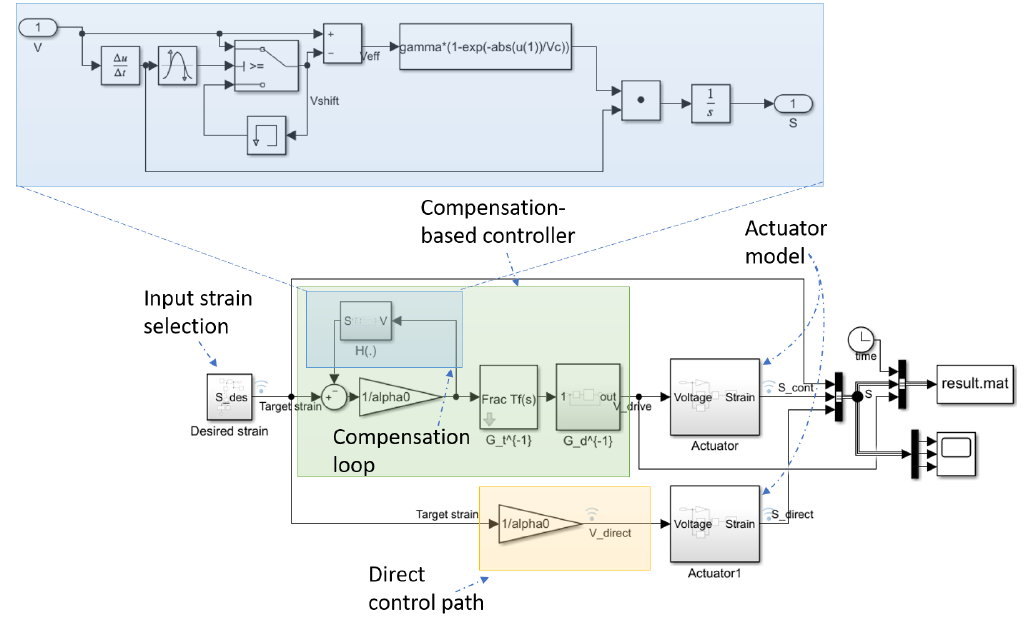
Figure 14. Schematic of the application example to linearized control.